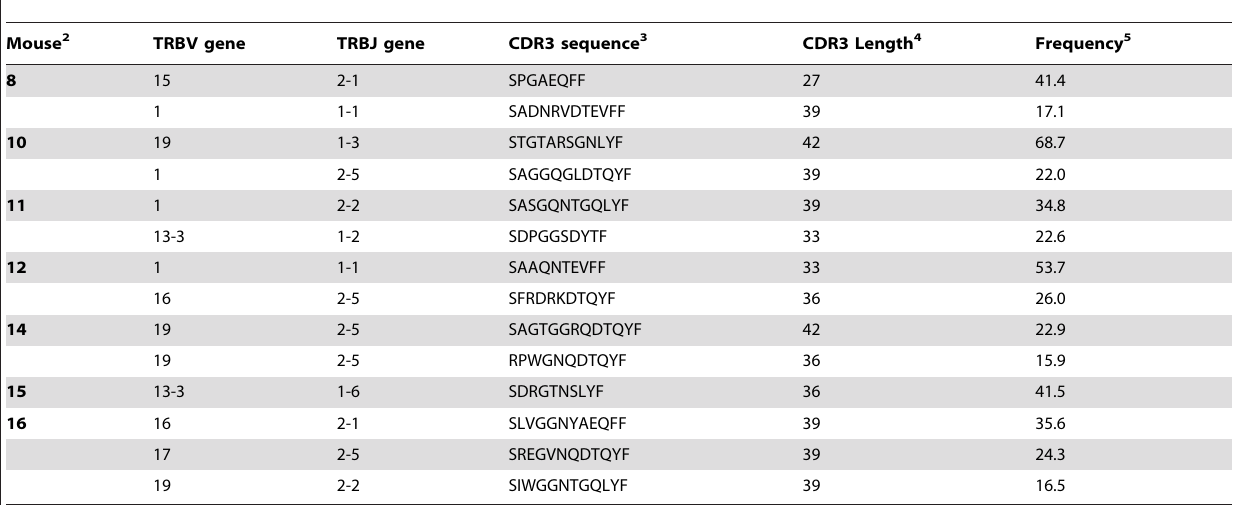
Table 2. Monoclonal expansions dominate the islet-infiltrating CD4 + CD44 high T cell repertoire at diabetes onset 1 .